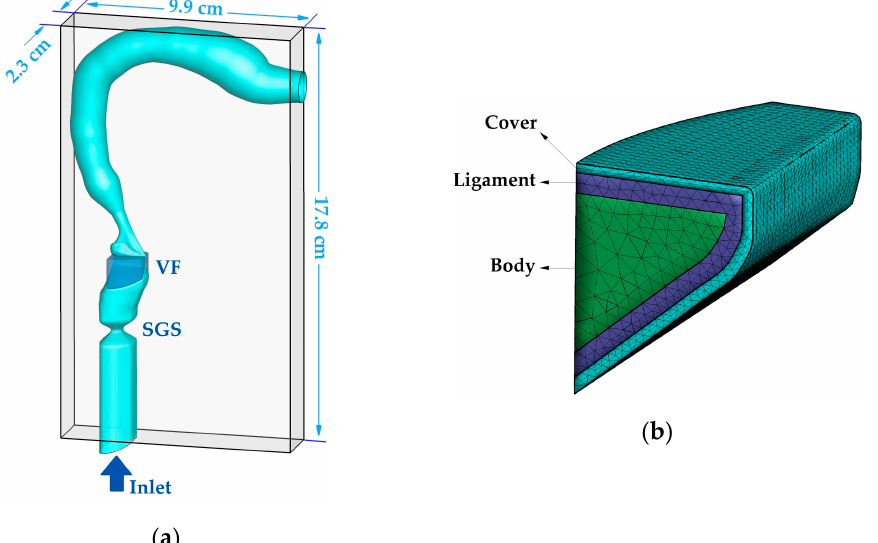
Figure 1. ( a ) The computational domain and geometry of the larynx, subglottic stenosis, vocal fold, and vocal tract. ( b ) The inner layers’ structure of the vocal fold.